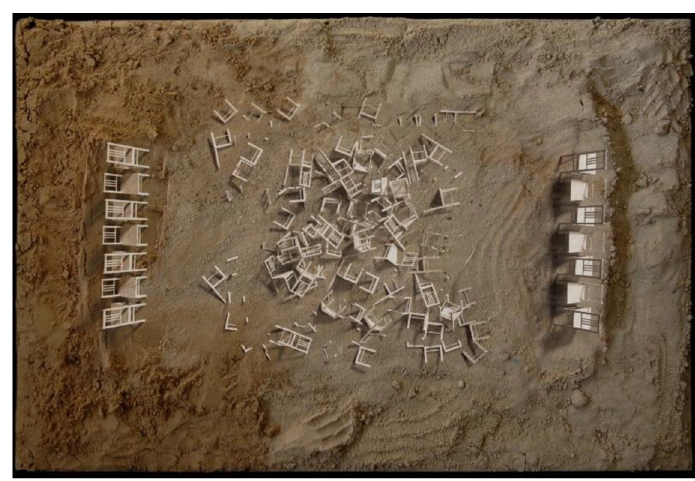
Figure 3. Ronen Sharabani, Sandbox , 2014. Projection on sand-table, 170 cm × 115 cm.